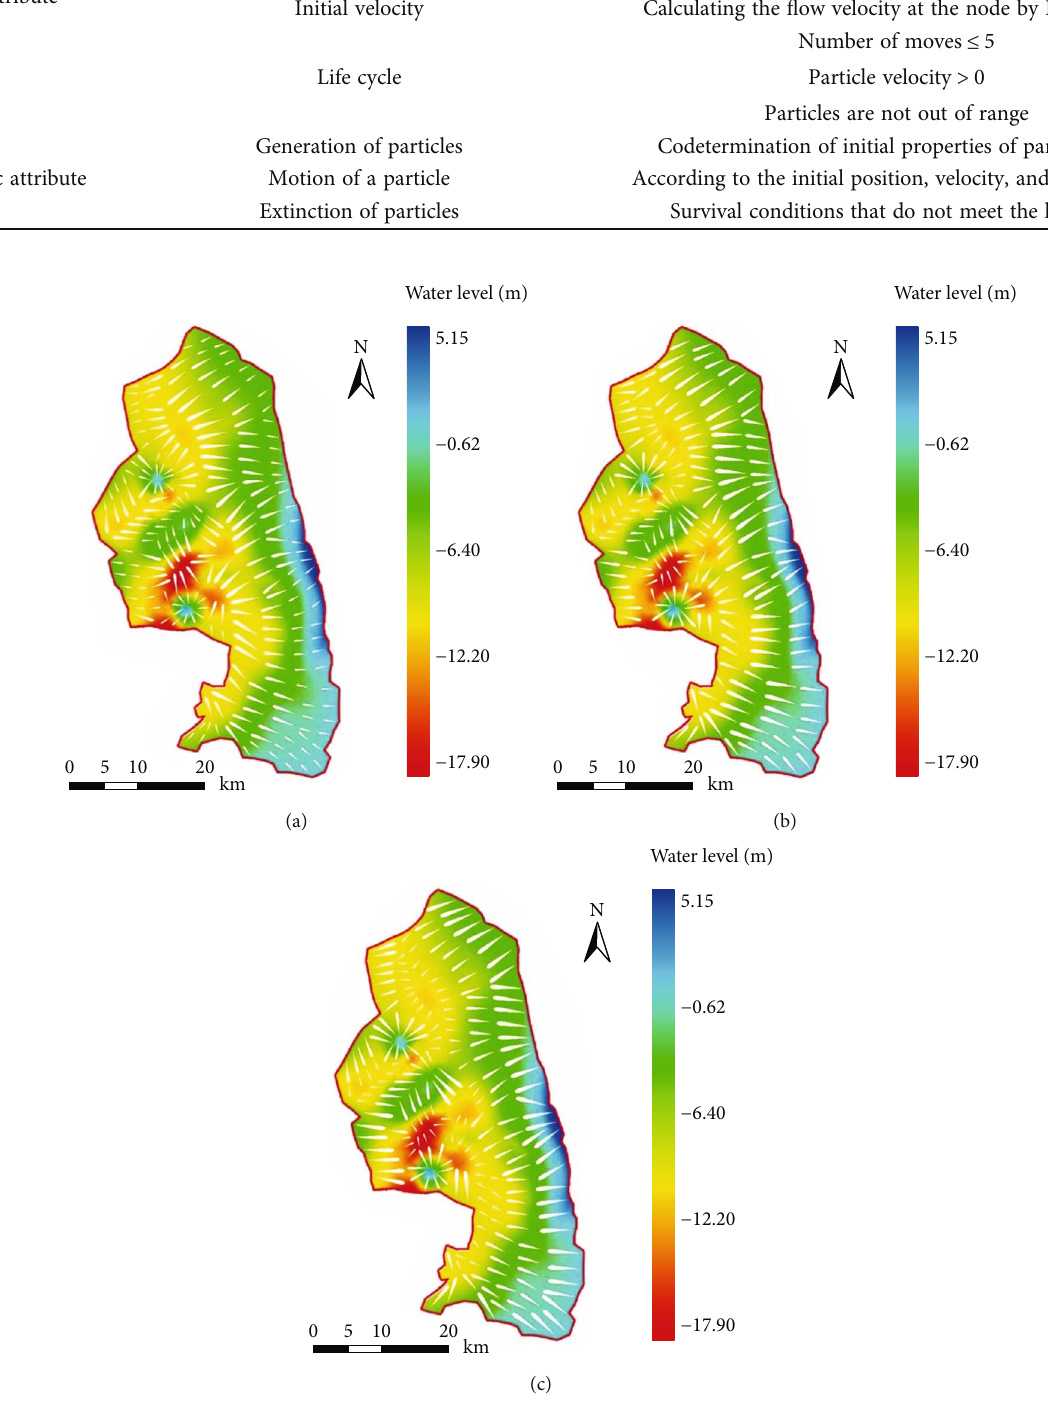
Figure 9: The visualization results of porous groundwater seepage fl ow fi eld based on particle fl ow